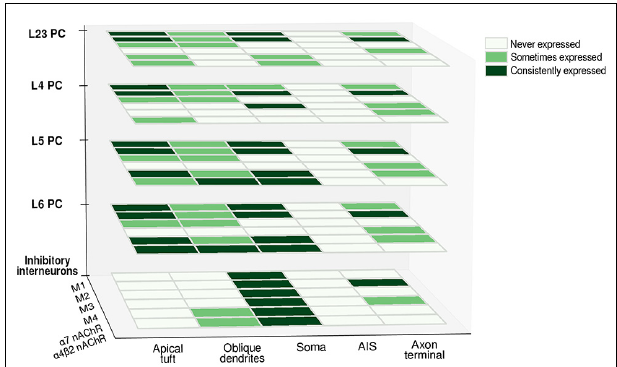
FIGURE 3 | Differential expression of cholinergic receptors in various neuronal compartments across cell-types. Heatmap matrices show the occurrence of cholinergic receptor subtypes at the level of different cell-types. The presence of a given subtype in a cellular compartment is classified as consistently expressed (consistent findings across experimental studies), sometimes expressed (evidence of its presence is only partial) and never expressed (presence of a given subtype is undetectable). Abbreviations: PC, pyramidal cell; M1, M2, M3, M4, muscarinic cholinergic receptors 1–4; nAChR, nicotinic acetylcholine (ACh) receptor.